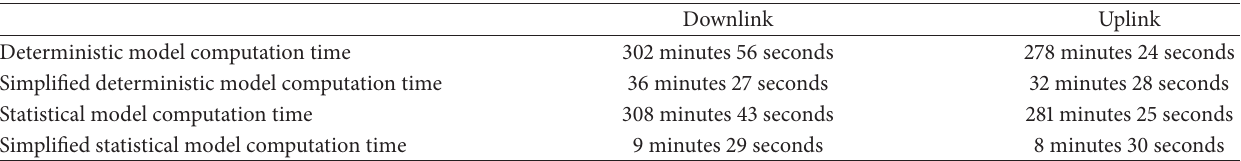
Table 2: Computation time of the models.